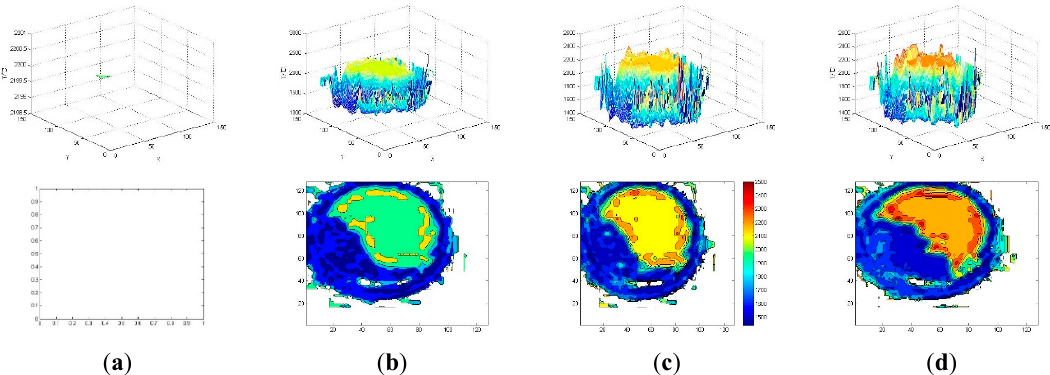
Figure 3. Calculated temperature field image of series 1 with MATLAB. ( a ) Ignition moment; ( b ) maximum pressure rise rate; ( c ) maximum heat release; ( d ) the highest pressure.